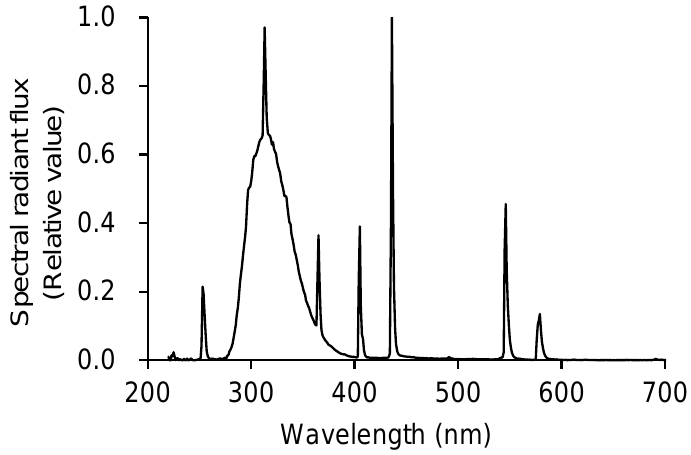
Figure 10. Spectral radiant flux from the UV-B lamp. Table 5. Spectral characteristic of the UV-B lamp. (UV-B intensity set at 0.1 W m −2 ).